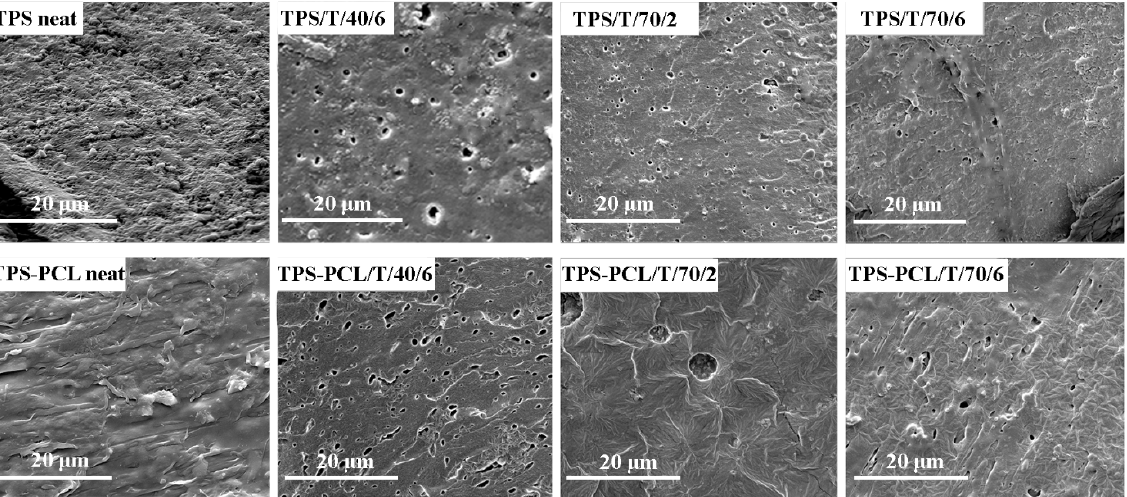
Figure 4. SEM micrographs of the fractured cross-section of neat and impregnated TPS and TPS– PCL samples.